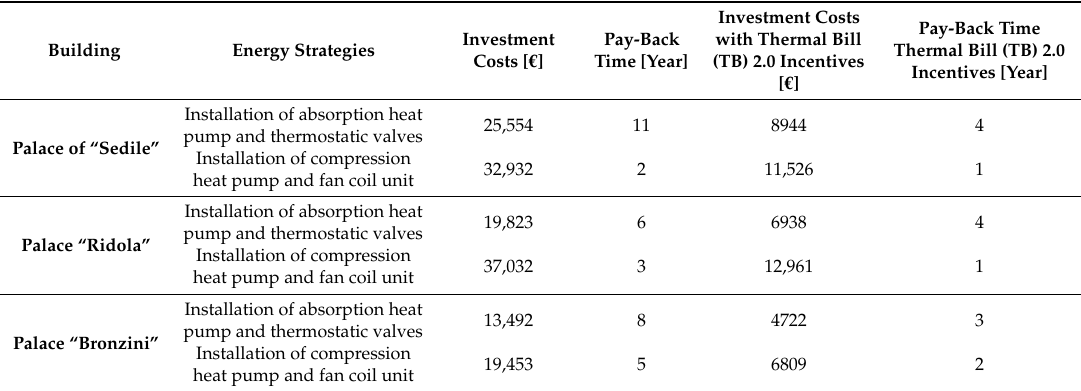
Table 15. Economic feasibility study on